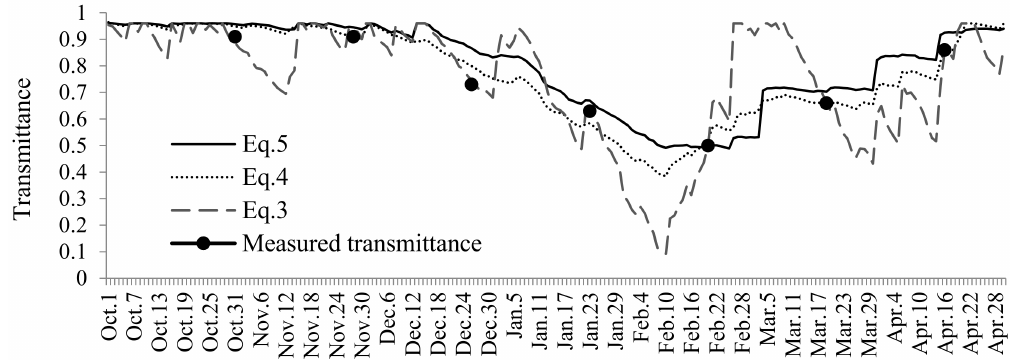
Figure 6. Estimated daily changes in transmittance and measured transmittances.